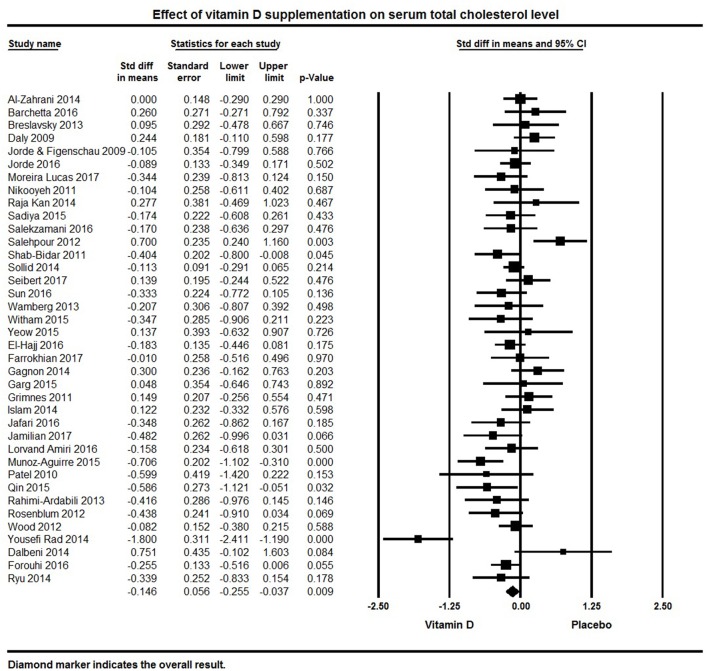
Forest plot detailing standardized mean difference for the impact of vitamin D on serum total cholesterol level.